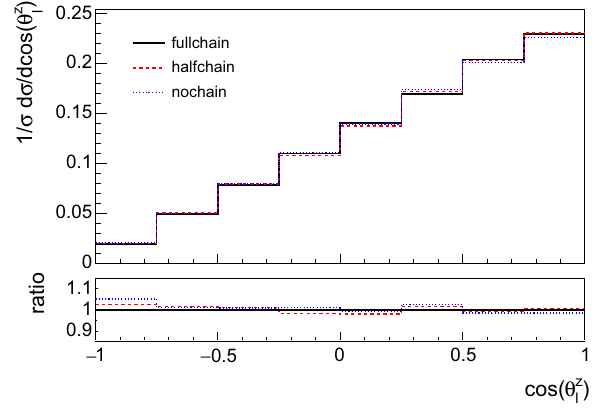
Fig. 4 The SM top polarisation angle at LO for the 3 different gen- eration options, as described in the text. The ratios with respect to the fullchain method are shown in the lower